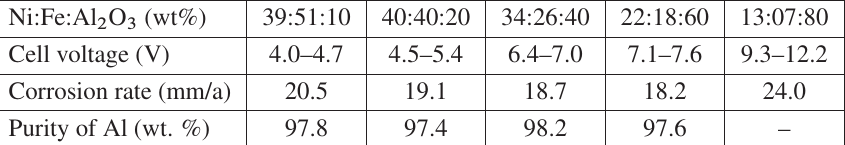
Table 2. Electrolysis results of Fe-Ni-Al 2 O 3 anodes.